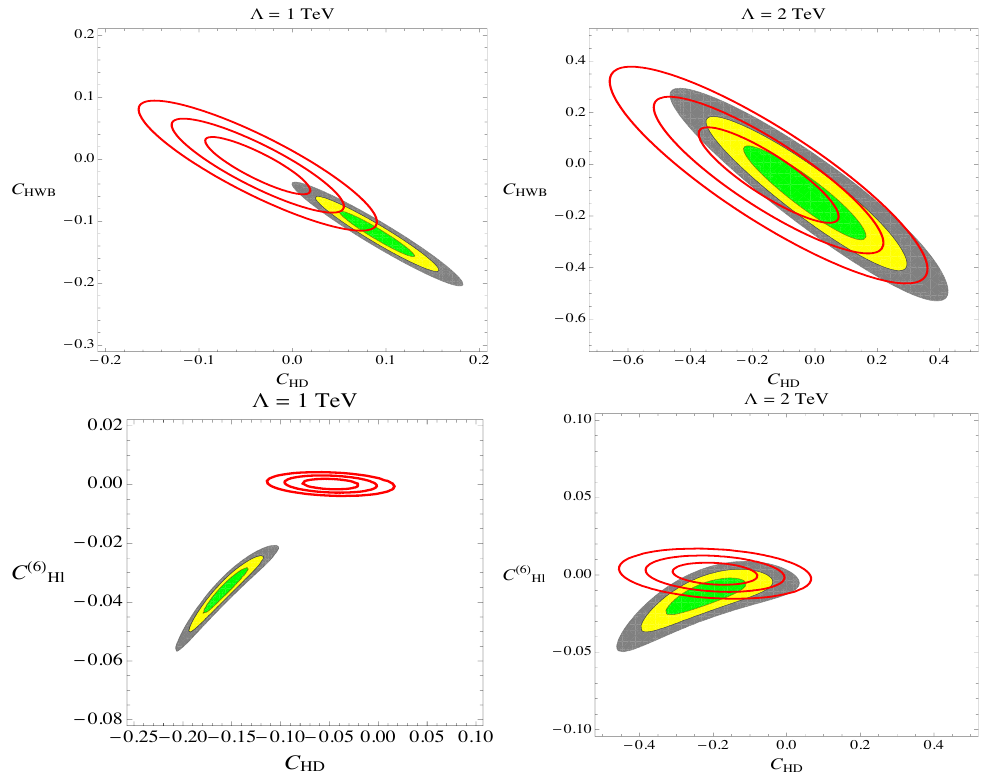
Figure 3 . The green/yellow/gray contours correspond to the 68% / 95% / 99 . 9% CL two parameter fit determined by ∆ χ 2 , while the red rings correspond to the same CL determined using O ( v 4 / Λ 4 ) ∆ χ 2 . In the top panels the free parameters are C HD and C HWB , while in the bottom panels O ( v 2 / Λ 2 ) the free parameters are C HD and C (6) . Note that the axes ranges vary from panel to panel. In the H‘ left panels, we have taken the scale Λ = 1 TeV, while in the right panels Λ = 2 TeV. All calculations use the ˆ m W